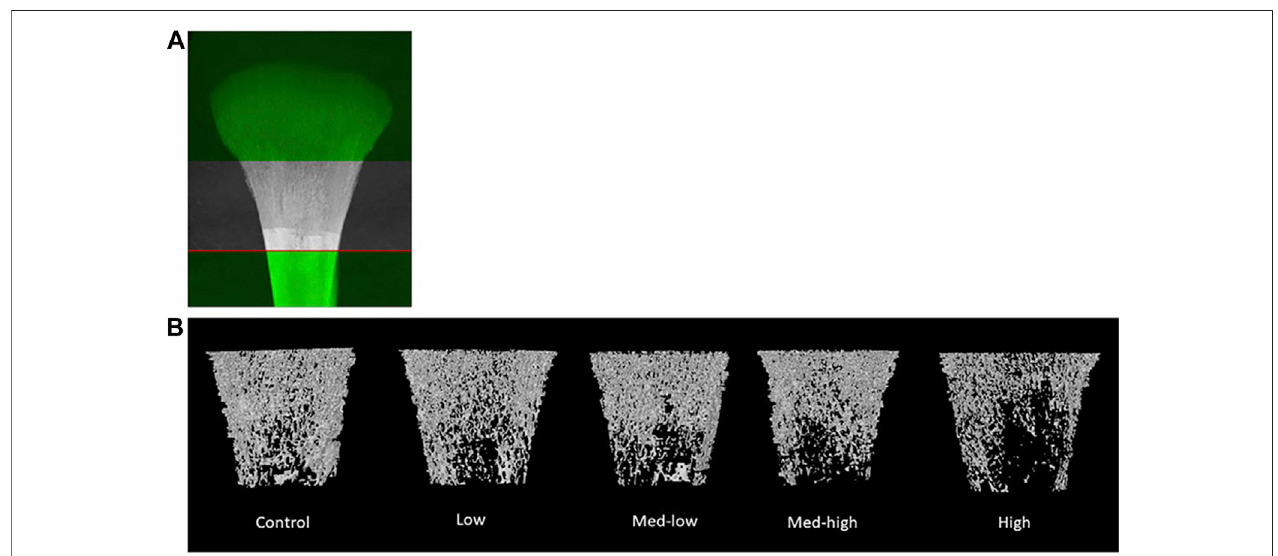
FIGURE 1 | (A) The selection of metaphyseal region of interest. (B) Representative reconstructed 2D images of broiler tibia metaphysis at six dpi (19 days of age). Metaphyseal structure analysis showed a lower bone mineral content and density coupled with impaired trabecular bone traits following the higher inoculation doses of Eimeria . The negative impact of Eimeria infection on bone traits was mainly located at metaphyseal trabecular bone.